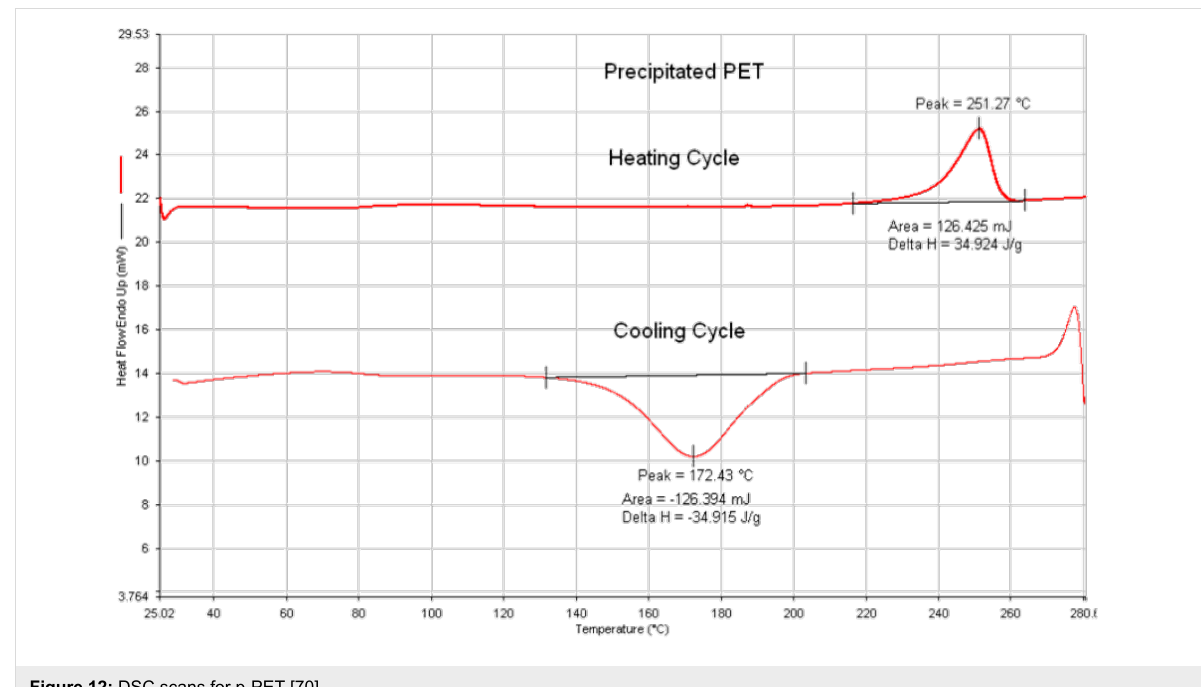
Figure 12: DSC scans for p-PET [70].